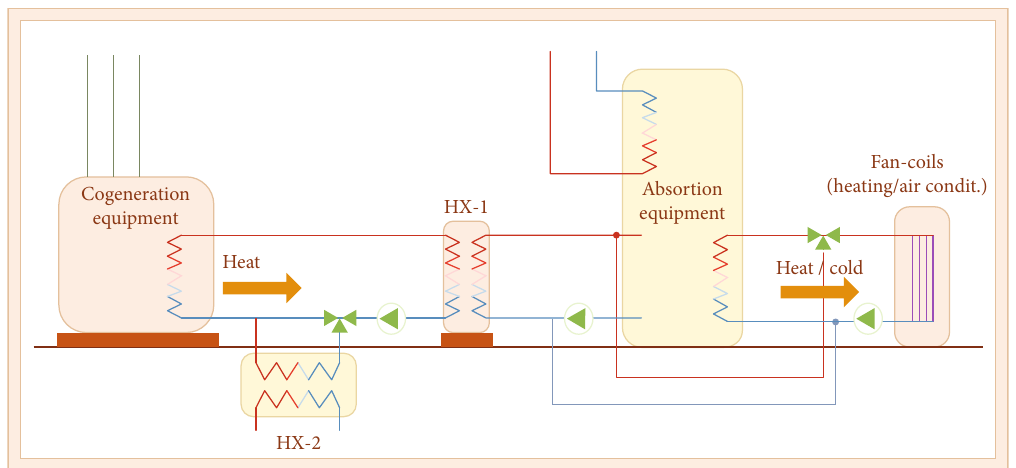
Figure 12: Advanced cogeneration system